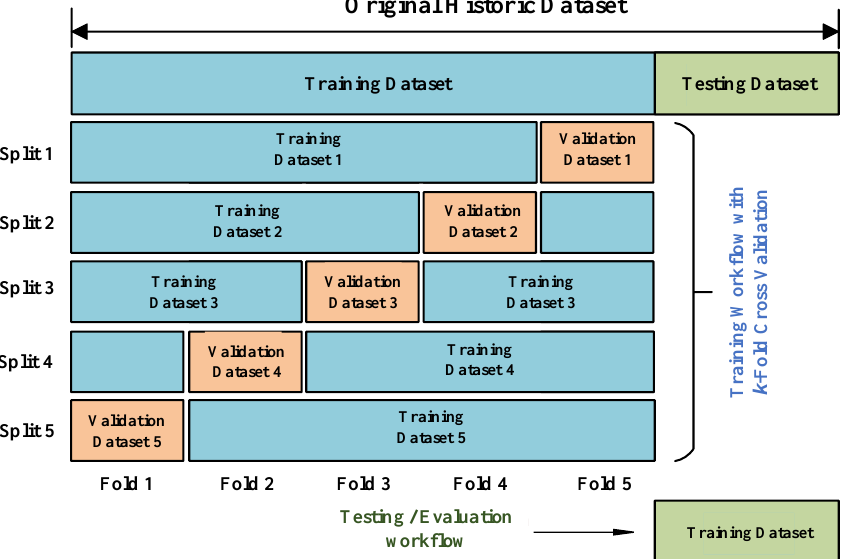
Figure 7. k-Fold cross-validation process.